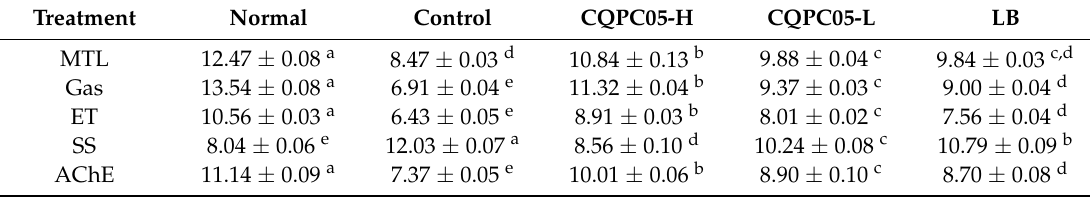
Table 2. SerumMTL,Gas,ET,SS,andAChElevelsof Lactobacillusplantarum CQPC05 and Lactobacillus delbruechii subsp. bulgaricus treated activated carbon-induced constipation